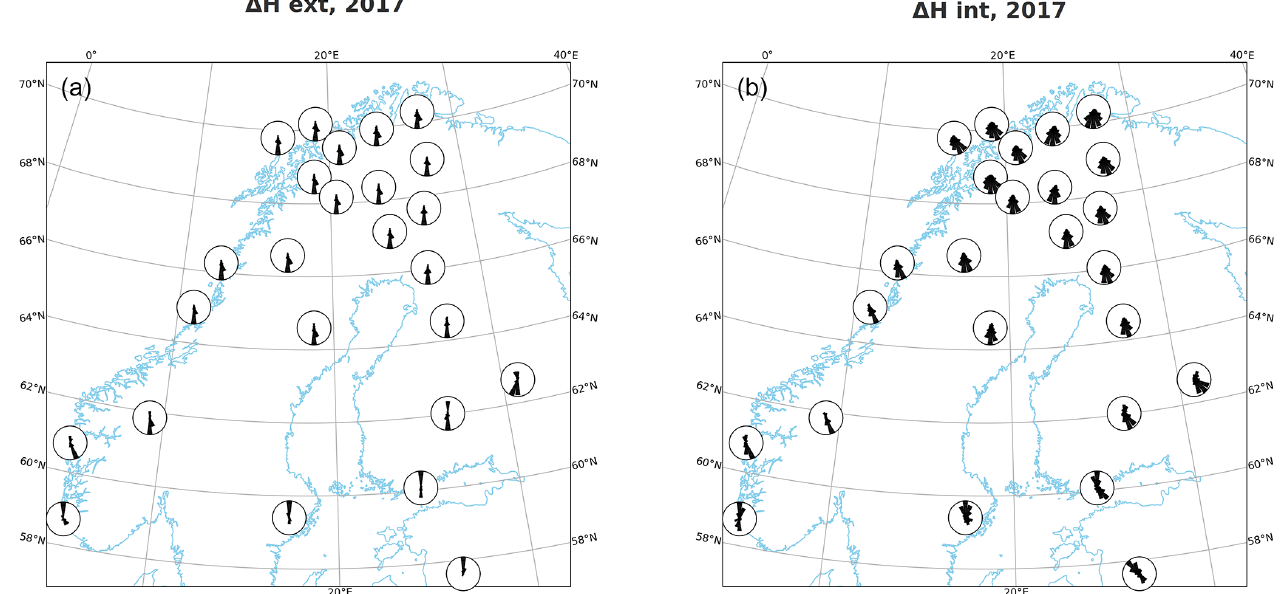
Figure 4. Directional distribution of external (a) and internal (b) (cid:49) H at IMAGE stations in 2017 when | d (cid:49) H / d t | > 1nTs − 1 .